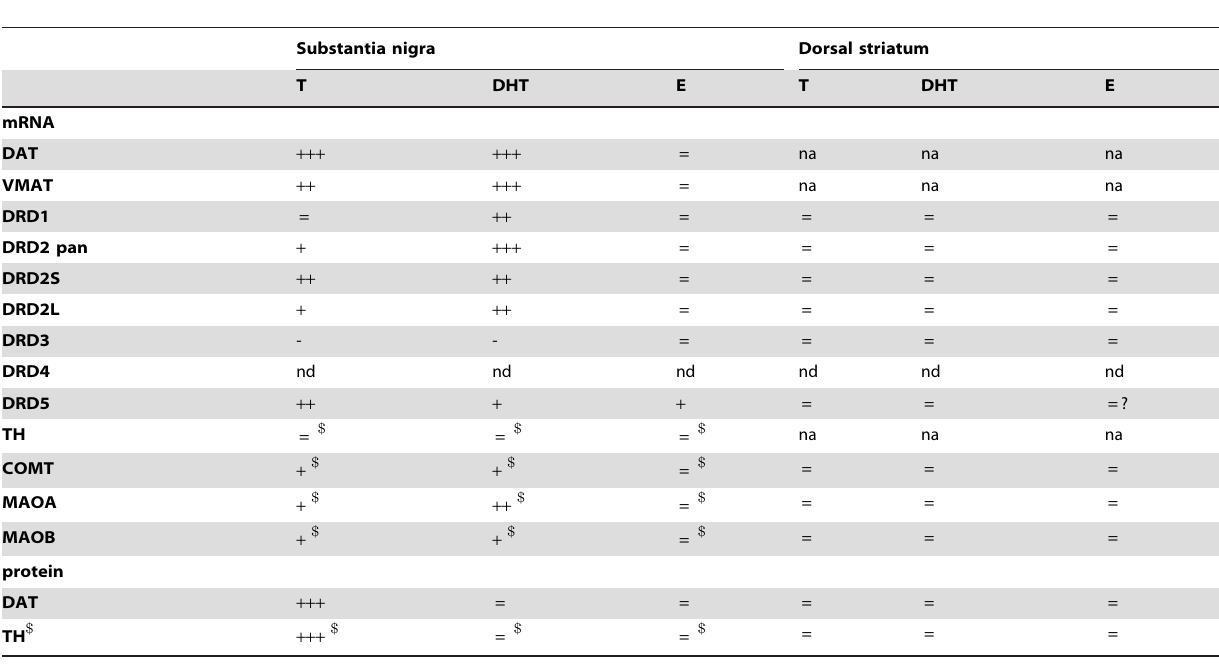
Substantia nigra Dorsal striatum T DHT E T